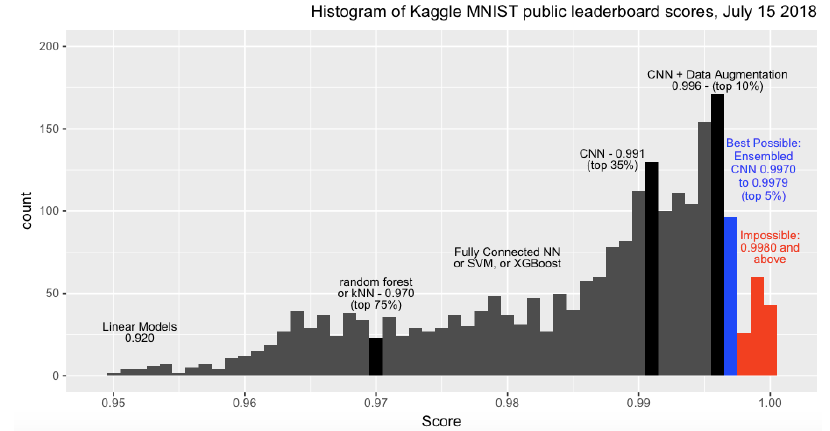
Figure 5 – Classification accuracy on the MNIST dataset (Deotte,